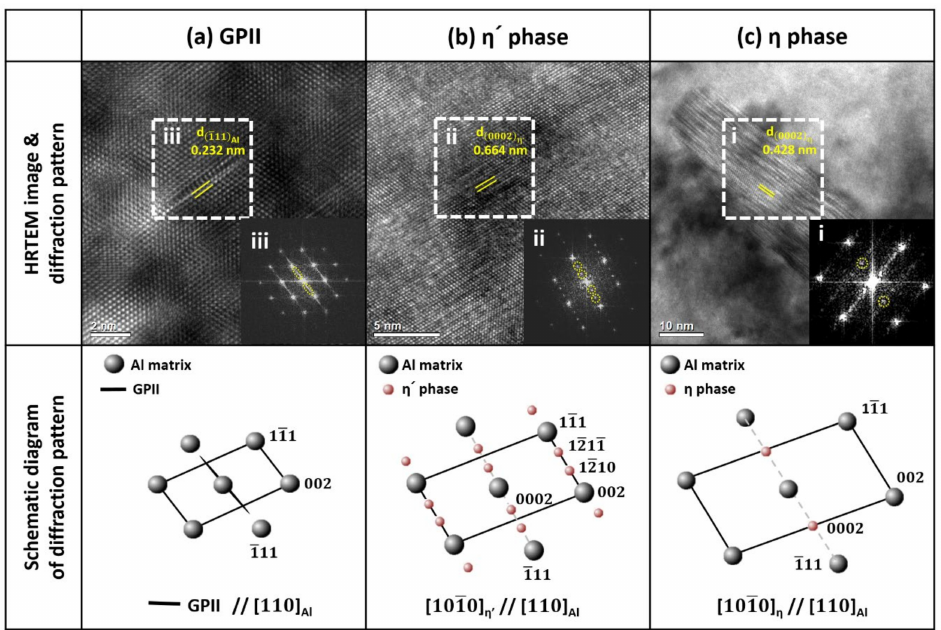
Figure 3. High-resolution TEM images of ( a ) GPII zones observed in E50-T4 and ( b ) η (cid:48) phase, and ( c ) η phase observed in an E50-T6